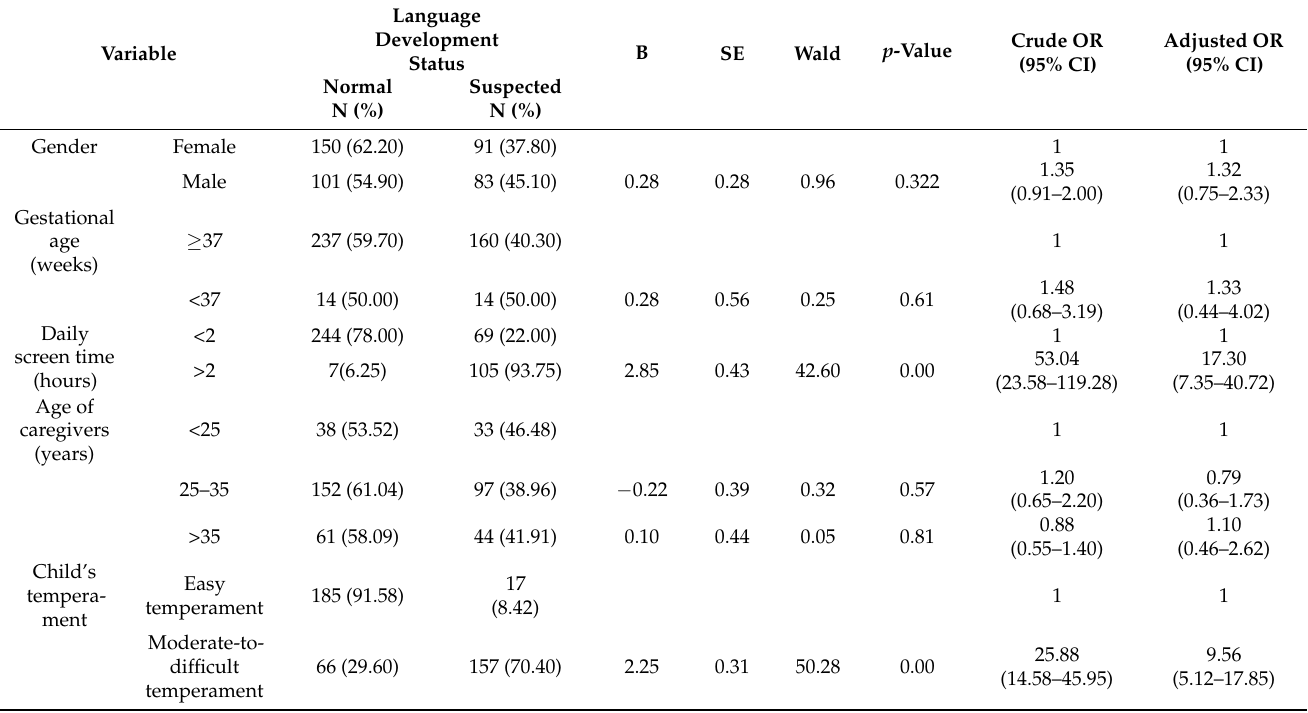
Table 4. Binary logistic regression analysis for exploring factors associated with a suspected delay in language development ( n =